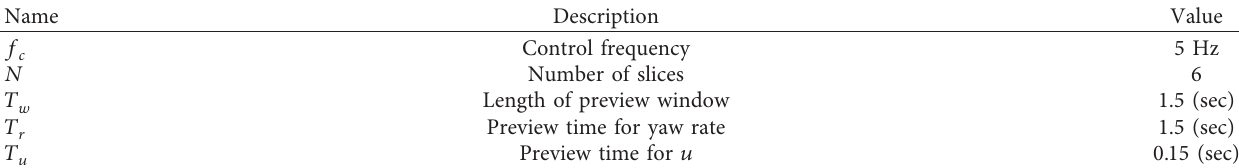
Table 2: Controller parameters.